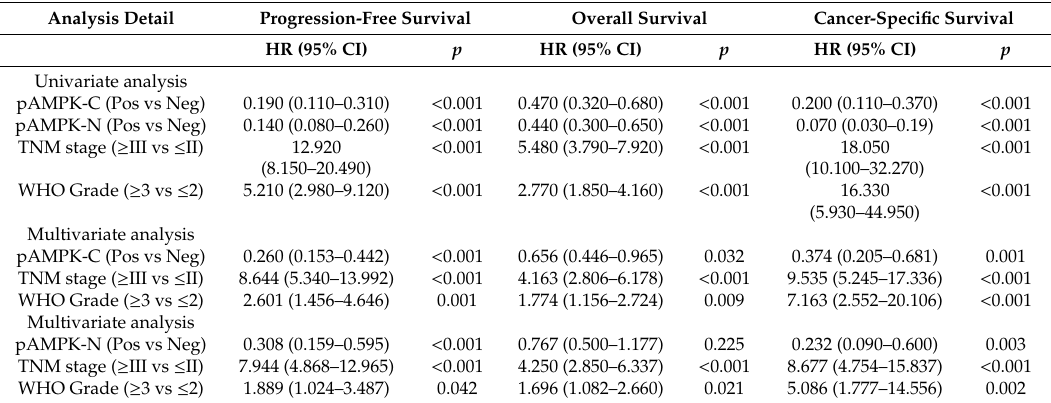
Table 2. Cox regression analyses for pAMPK expression of the discovery cohort.